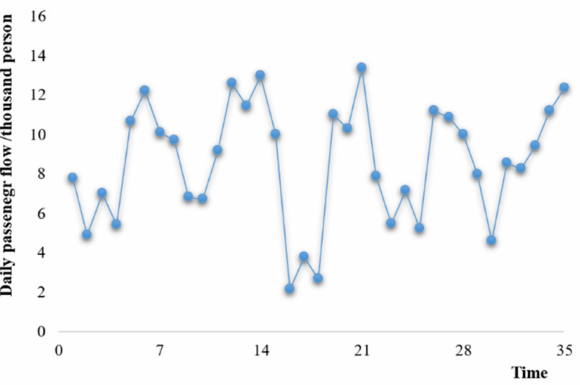
Figure 1. The distribution of daily passenger demand at Jingzhou station over two months.